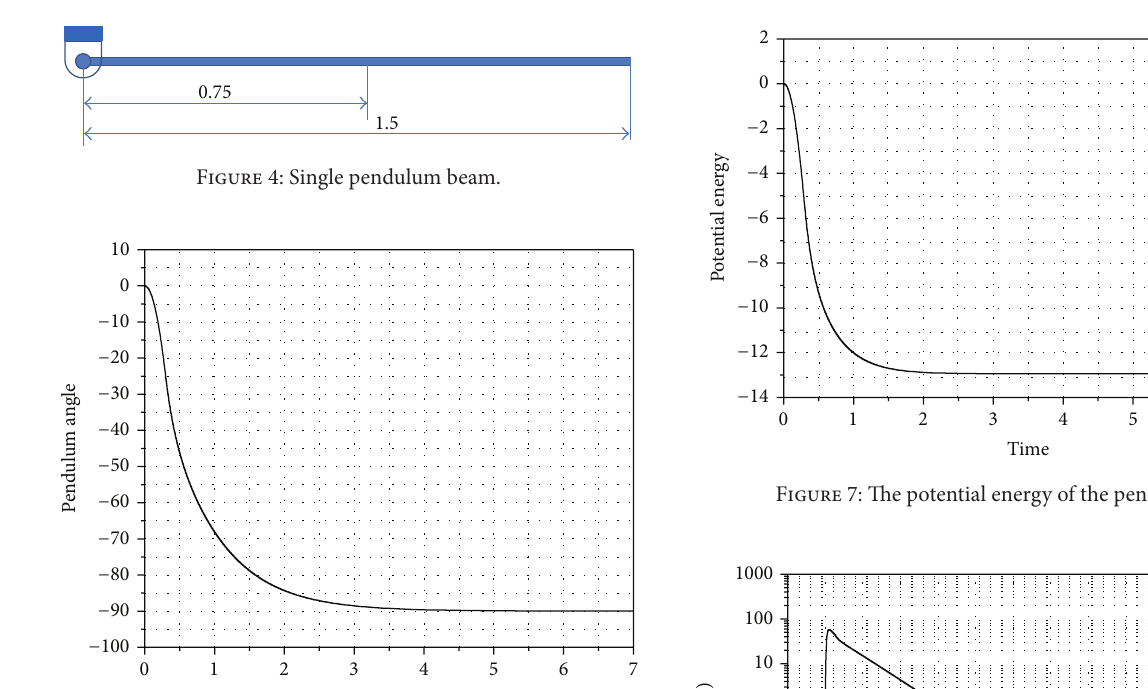
Figure 5: The pendulum angle as it falls under the effect of gravity.